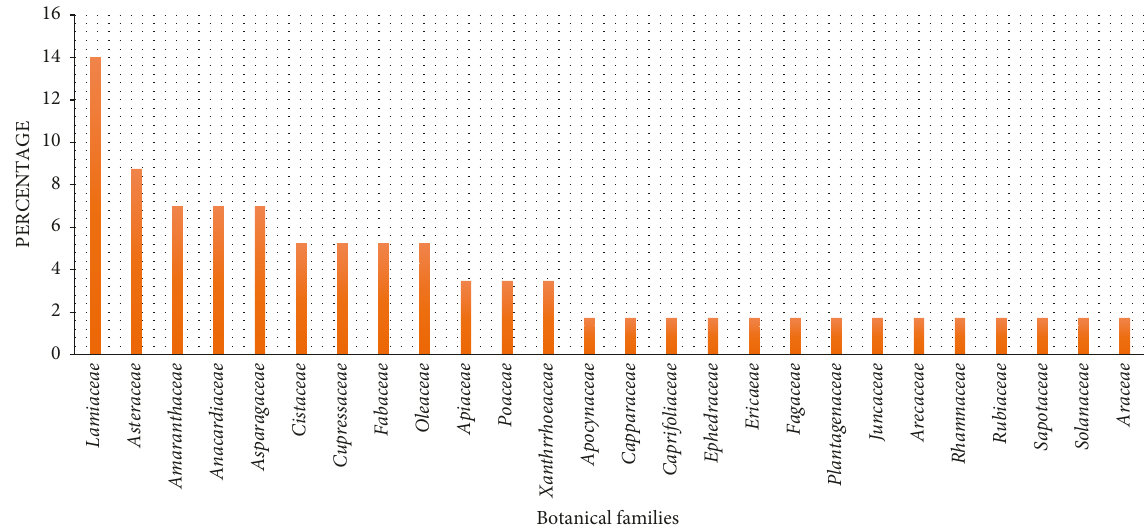
Figure 2: Distribution of botanical families according to specific medicinal richness. Classification of the degree of toxicity of